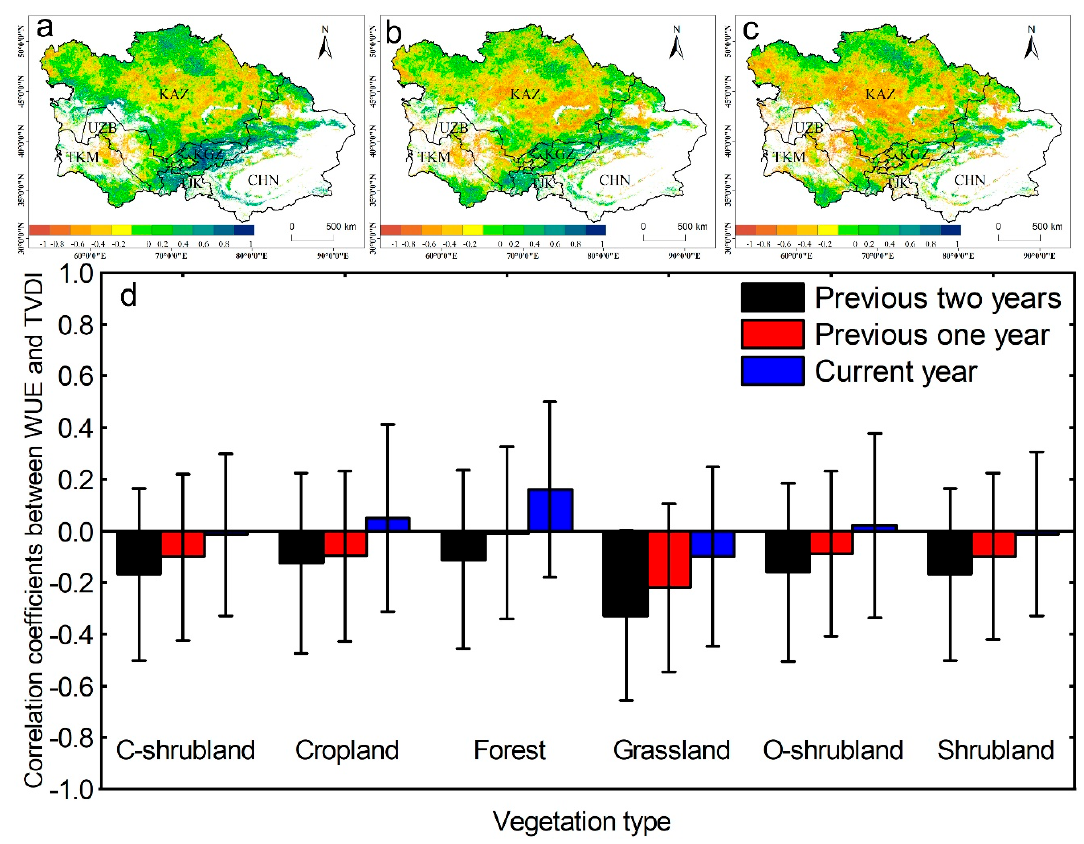
Figure 5. Correlation coefficients between WUE and the TVDI of the ( a ) current year, ( b ) previous one year, and ( c ) previous two years for the period 2000–2010; ( d ) the correlations in different vegetation types. White areas represent barren, snow, and water body pixels.